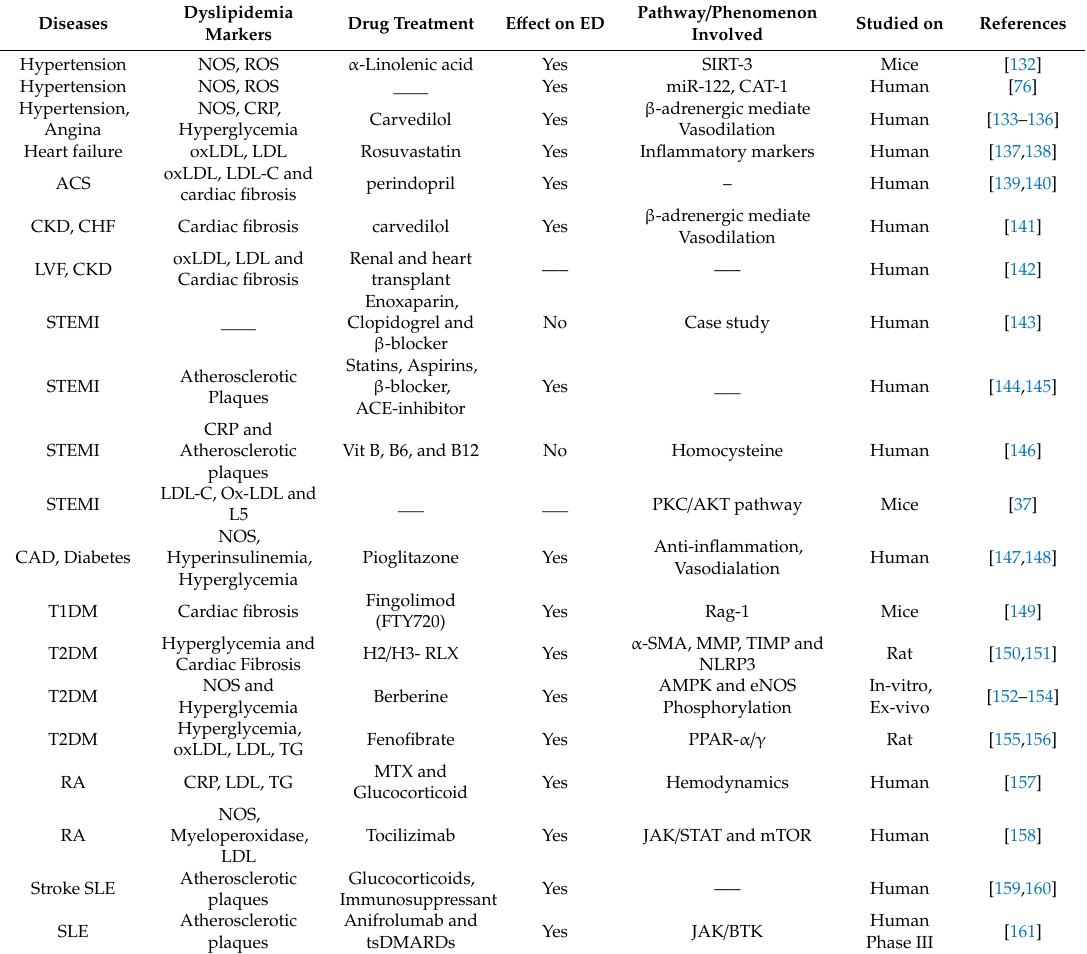
Table 1. Primary dyslipidemia markers and pathways involved in di ff erent